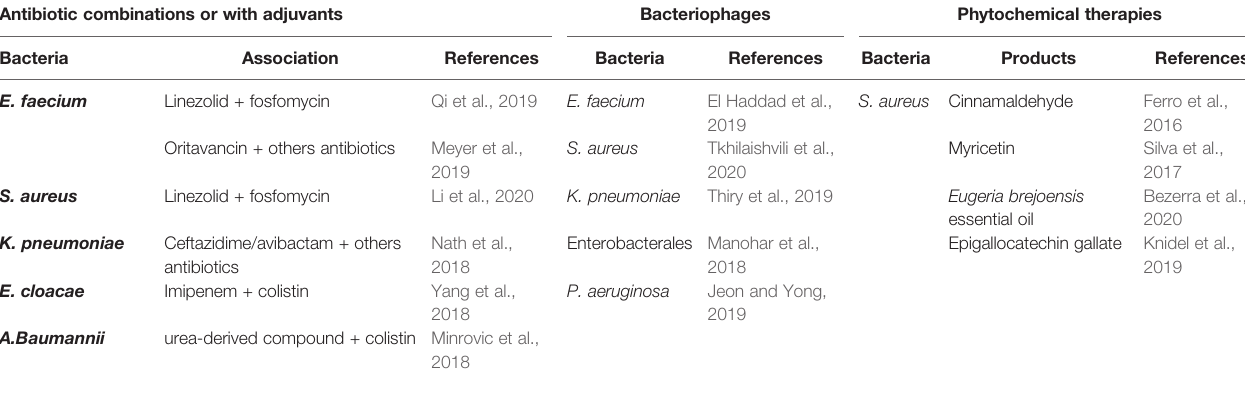
TABLE 2 | Utilization of G. mellonella larvae as a screening model to test the ef fi cacy of new antibacterial therapies. Antibiotic combinations or with